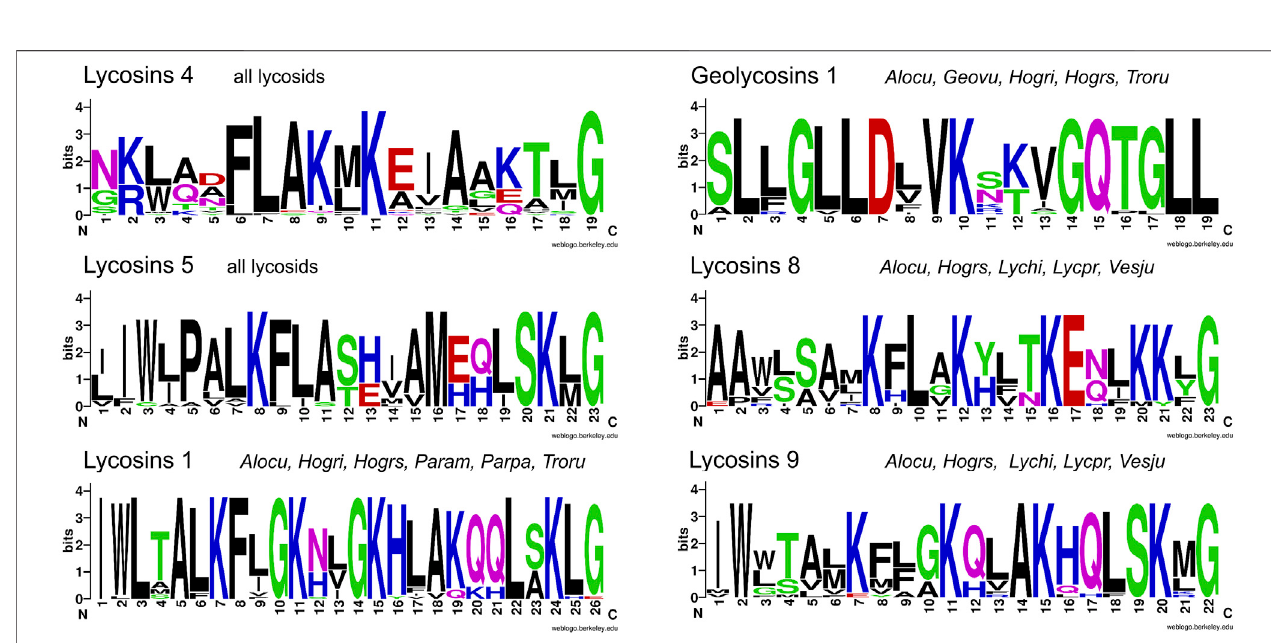
FIGURE 10 | Overview of sequence logos of selected LP families of lycosids. Peptides of the lycosin 4 and 5 families are shared by all lycosids and peptides of the lycosin 1, geolycosin 1, lycosin 8, and lycosin 9 families are shared by only some species. The relative frequency of each amino acid residue at a certain position of different lycosid peptide families is given as a sequence logo. Cationic amino acids are colored in blue, anionic amino acids in red, the corresponding C-terminal amid variants in pink, hydrophobic amino acids in black, and polar amino acids in green. Alocu ( Alopecosa cuneata ), Geovu ( Geolycosa vultuosa ), Hogri/Hogrs ( Hogna radiata Italy/Spain), Lychi ( Lycosa hispanica ), Lycpr ( Lycosa praegrandis ), Param ( Pardosa amentata ), Parpa ( Pardosa palustris ), Troru ( Trochosa ruricola ), and Vesju ( Vesubia jugorum ).